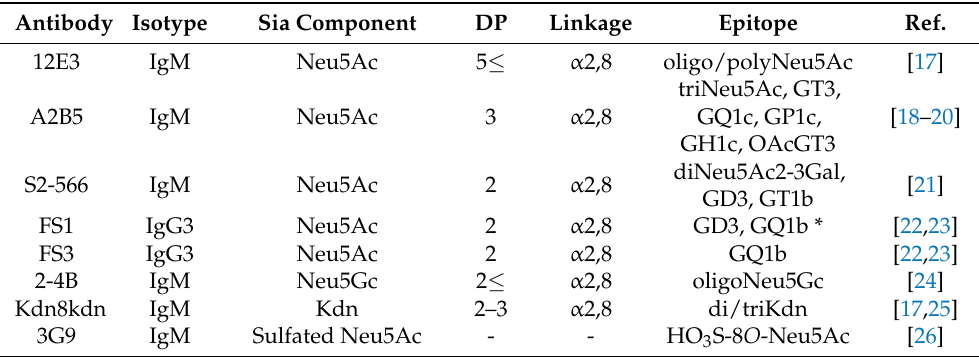
Figure 3. Flow cytometric analysis of cancer cell lines using anti-non-human sialic acid antibodies. In each histogram, black line, negative control (control antibody); blue line, anti-sialoglycoconjugate antibodies (mouse IgM), 2-4B ( A ) and kdn8kdn ( B ). Green line, anti-sialoglycoconjugate antibodies, 2-4B ( A ) or kdn8kdn ( B ), in the presence of 0.1 mM Neu5Gc ( A ) or 0.1 mM Kdn ( B ), respectively. Table 2. Anti-sialoglycoconjugate antibodies.